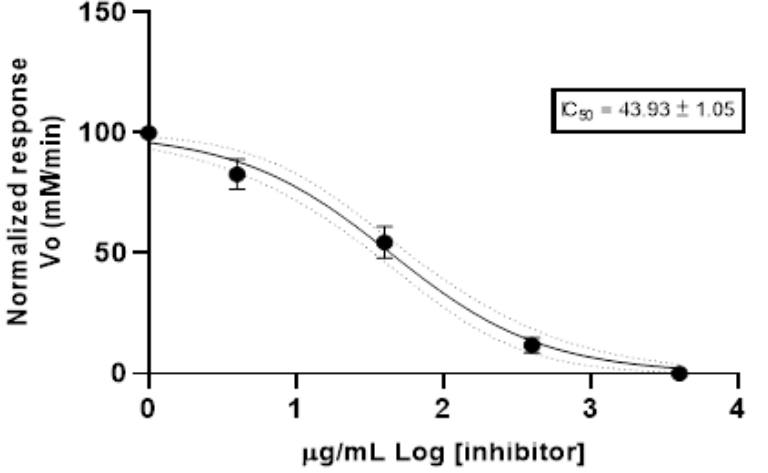
Figure 1. Anticholinesterase activity of essential oil from Peperomia inaequalifolia .